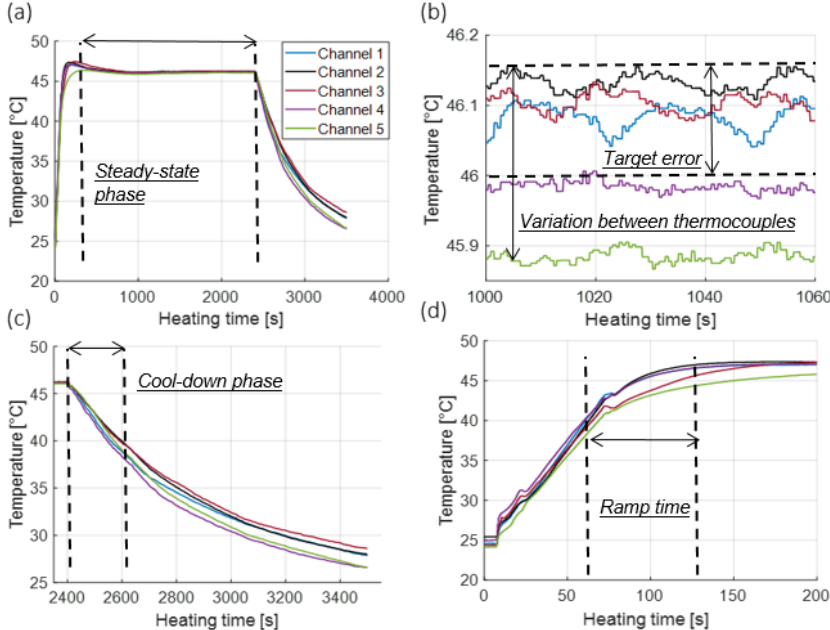
Figure 2. ( a ) Illustration of temperature recorded by thermocouples in the dummy plate during a 46 °C, 40 min hyperthermia exposure ( b ) illustration of temperatures over 1 min of the steady-state phase ( c ) illustration of temperatures during the cool-down phase, and ( d ) illustration of temperatures during the heat-up phase. Table 1. Assessment of transient temperature profiles during in vitro heating.